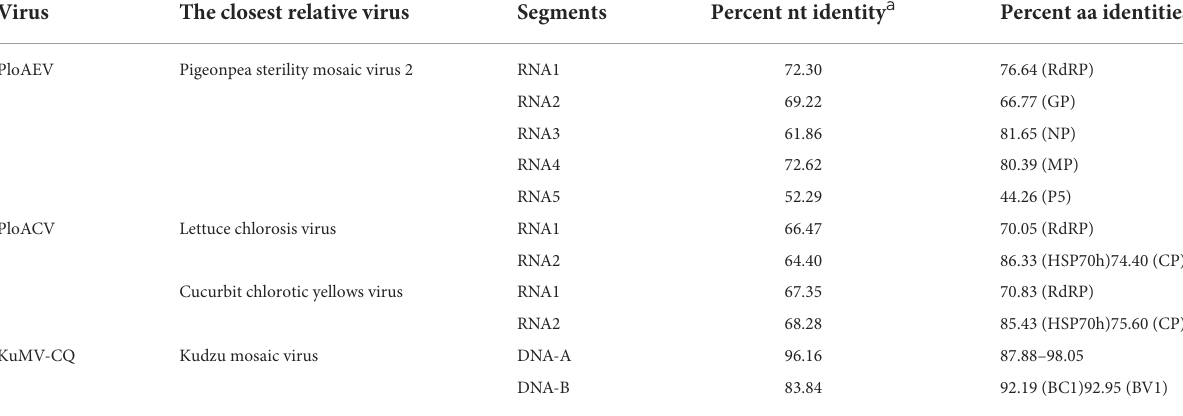
TABLE 2 The sequence percent identities on nucleotide (nt) and amino acid (aa)